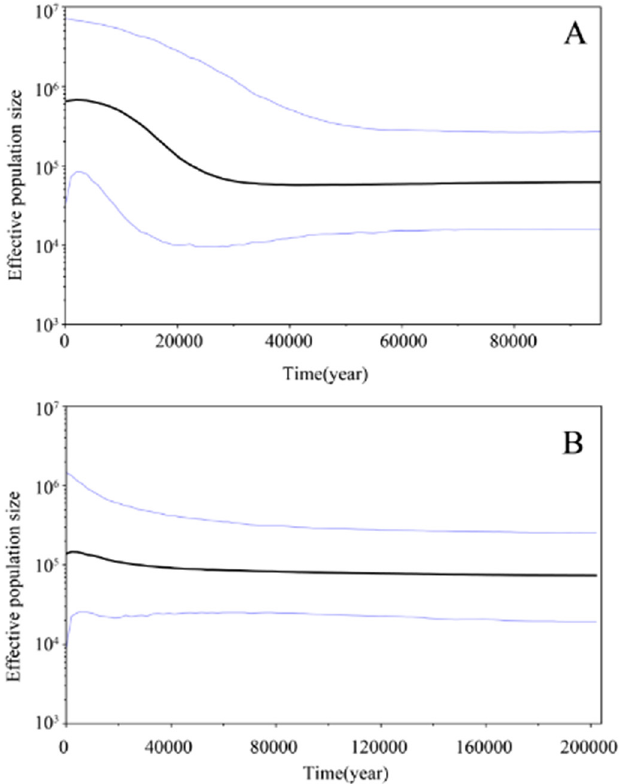
Fig. 4. Bayesian skyline plots showing N ef T ( N ef = effective population size; T = generation time) changes over time for P. chinensis based on the CR sequences. The upper and lower limits of the blue trend represent the 95% con fi dence intervals of the highest posterior density (HPD) analysis. The black line is the median estimate for N ef T